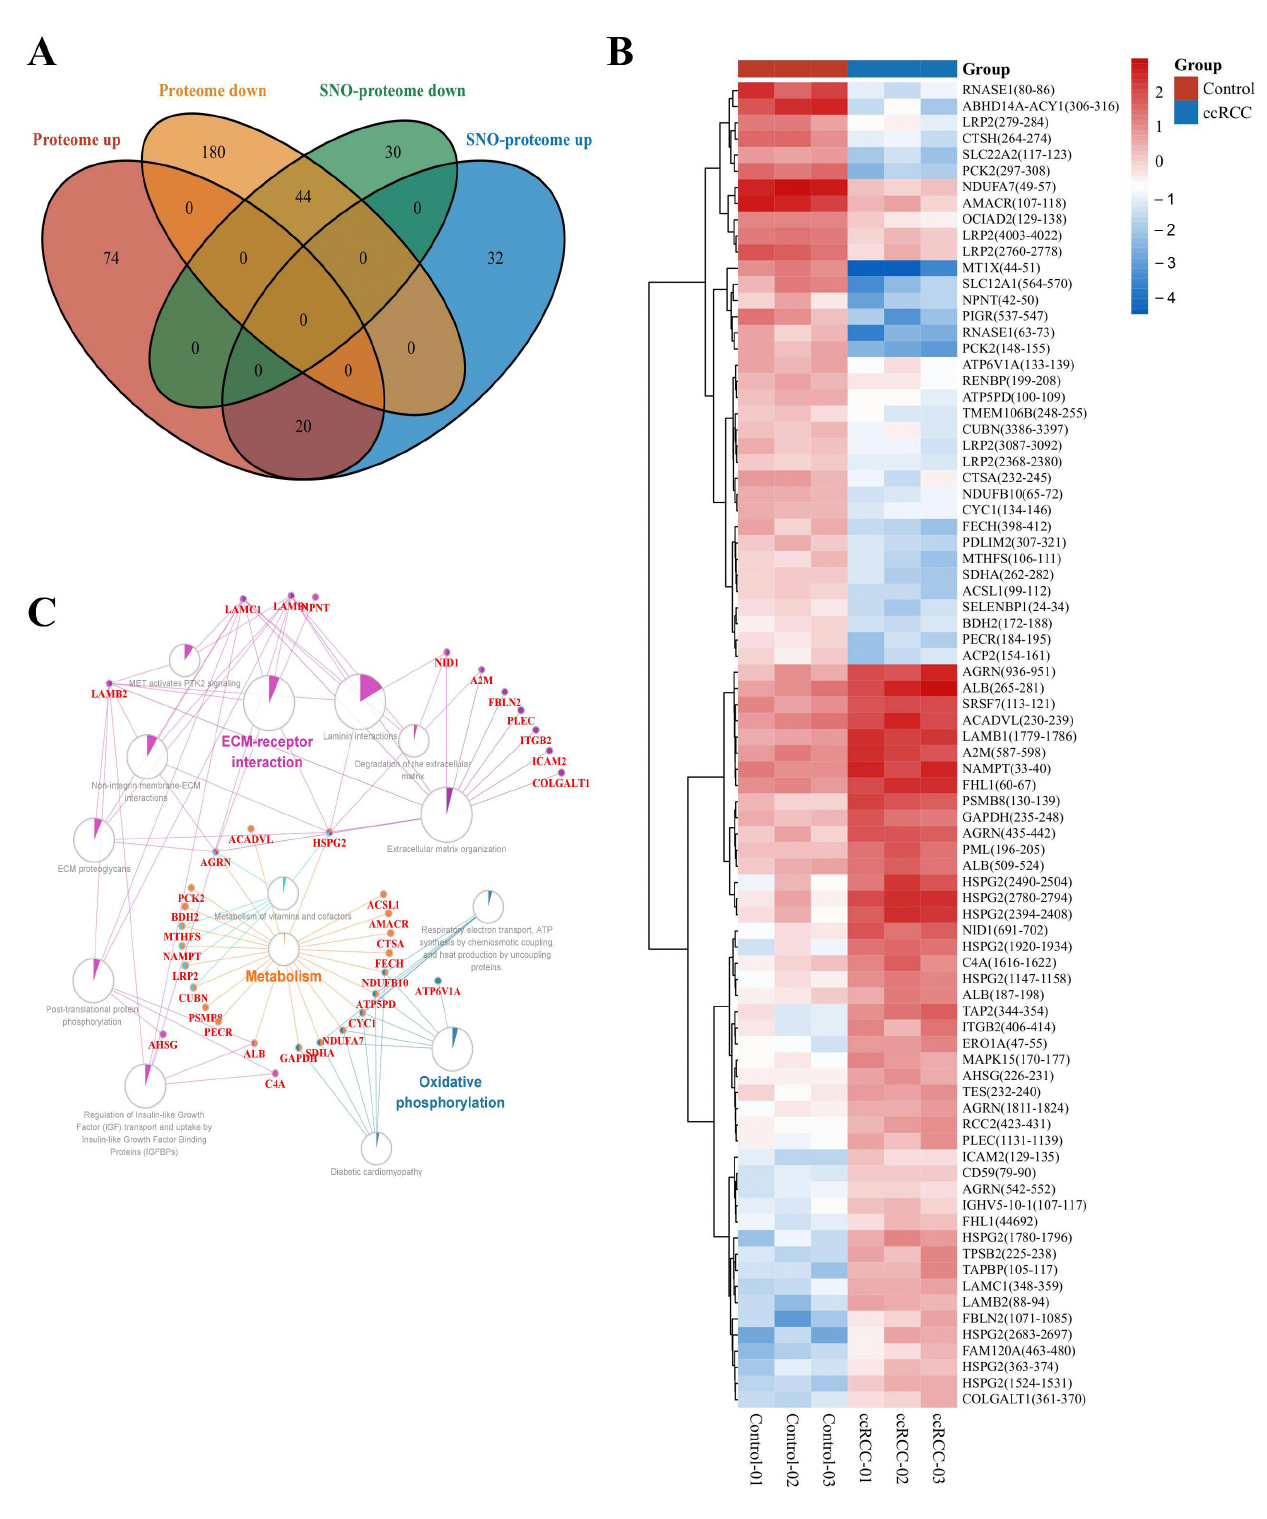
Figure 6. Molecular patterns of independently differentially expressed SNO proteins. ( A ) Venn diagram of differentially expressed SNO proteins vs. differentially expressed proteins; ( B ) heatmap of independently differentially expressed SNO − cysteine sites; ( C ) pathway − protein interaction network analysis of independently differentially expressed SNO proteins.